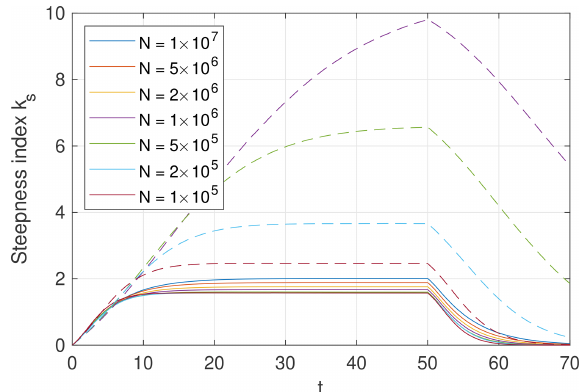
Figure 10. Mean steepness index k s of the large rivers obtained from simulations on TINs with different resolutions, defined by the total number of nodes N . Solid lines refer to the simplified scaling approach suggested in this paper (Eq. 16), while dashed lines re- fer to simulations performed without any rescaling. The latter are plotted only for N ≤ 10 6